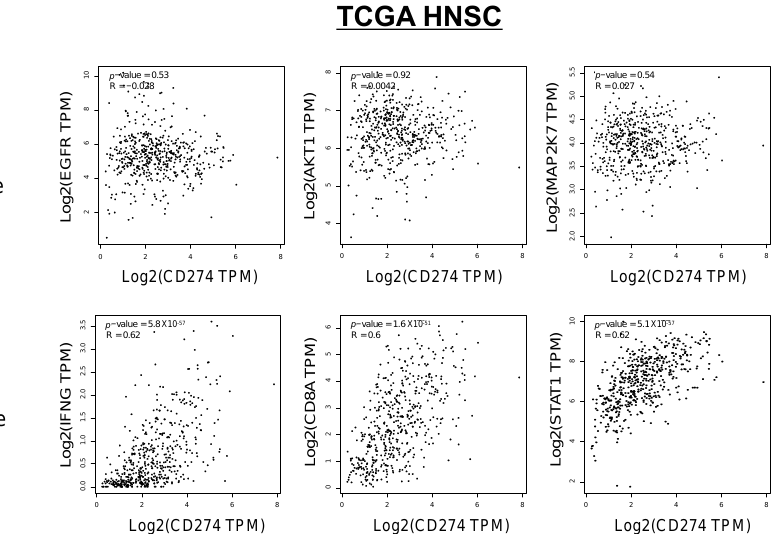
Figure 6. Correlation between IFN- γ -related genes, EGF-related genes, and PD-L1 expression in the TCGA HNSC dataset. Referring to the TCGA HNSC tumor dataset, we investigated the correlation between IFN- γ -related genes (IFN- γ , CD8A, and STAT1), EGF-related genes (EGFR, AKT1, and MAP2K7), and PD-L1 (CD274).